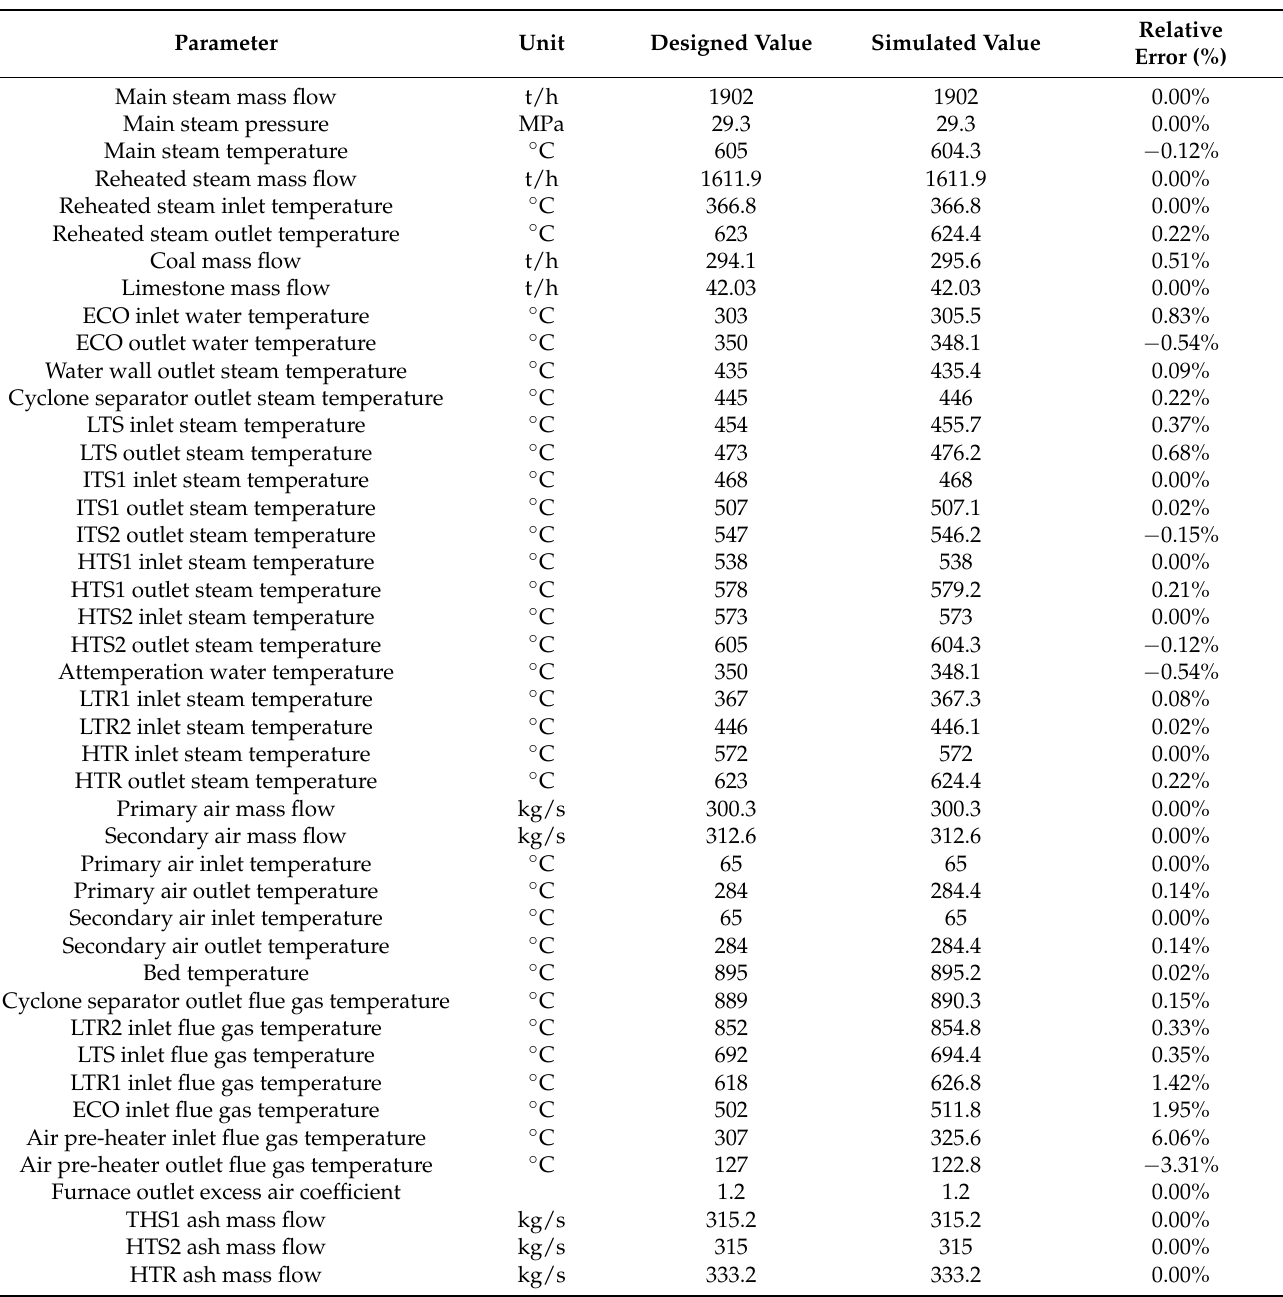
Table 3. Simulation results at 100%